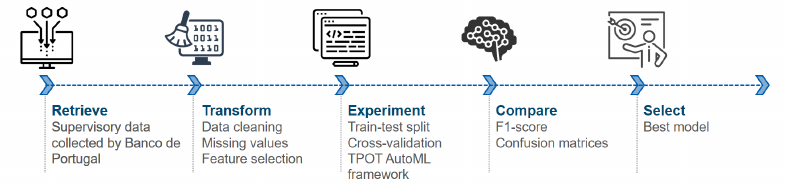
Figure 1. Methodology process